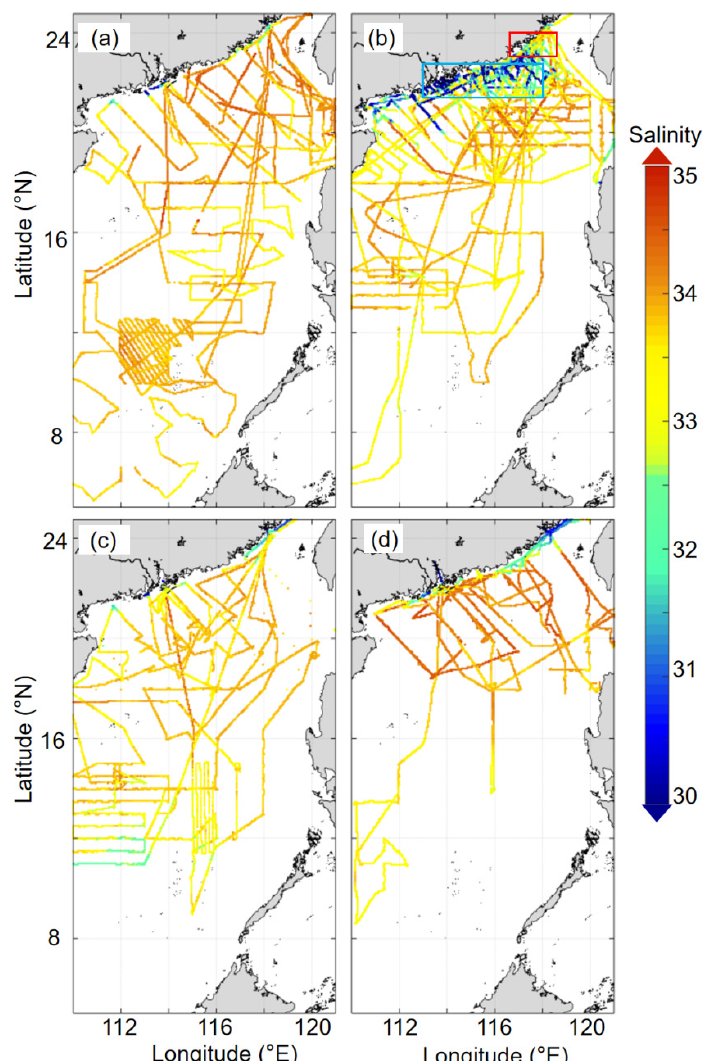
Figure 4. Distribution of temporally averaged underway sea surface salinity (SSS) in the South China Sea during four seasons. The green box in panel b indicates the area influenced by the Pearl River plume, and the red box indicates the area influenced by coastal upwelling. The data sources are listed in Table 1 (( a ). Spring; ( b ). Summer; ( c ). Fall; ( d ). Winter).